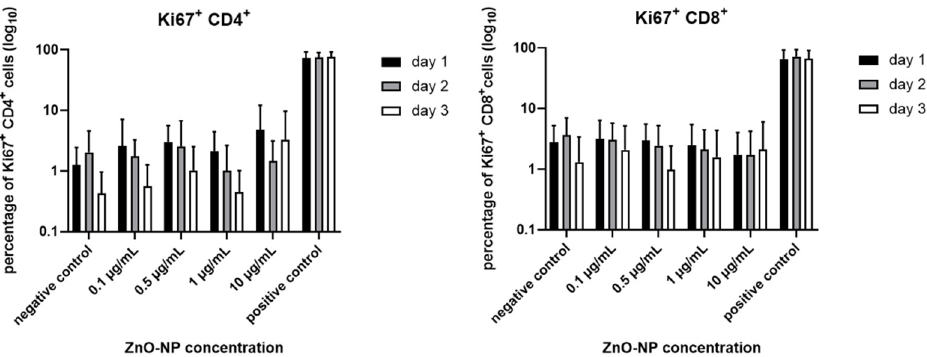
Figure 4. Ratio of Ki67 + in CD4 + and CD8 + T cells. There is a tendency towards a decrease in T cell activation over time. Data are plotted logarithmically, there is no statistical significance in terms of dose and time dependence. Data represent the mean +/ − standard deviation (n = 9 for day 1 and 2, n = 7 for day 3 for CD4 + cells; n = 7 for day 1, n = 6 for day 2 and 3 for CD 8 + cells).